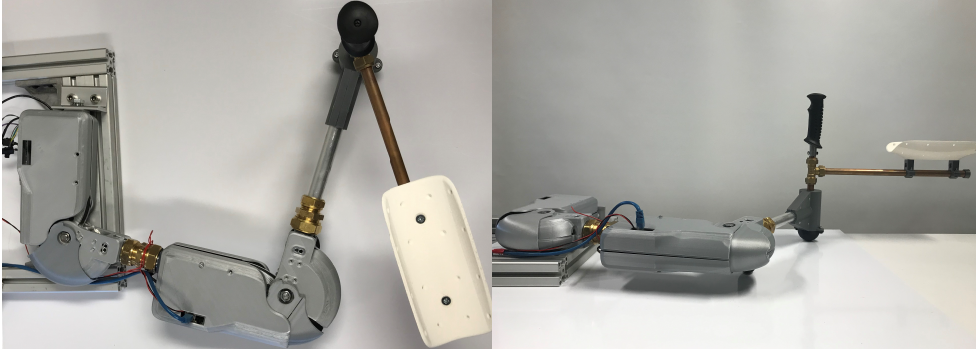
Figure 13. Upper-limb rehabilitation prototype built with two SMARCOS. The device can provide assistance with a variable stiffness configuration to adapt to the needs of the subject. The device is easy to assemble/disassemble to facilitate transportation. The system only requires a table to be clamped to, and a computer to acquire the data, as pictured in Figure 14.